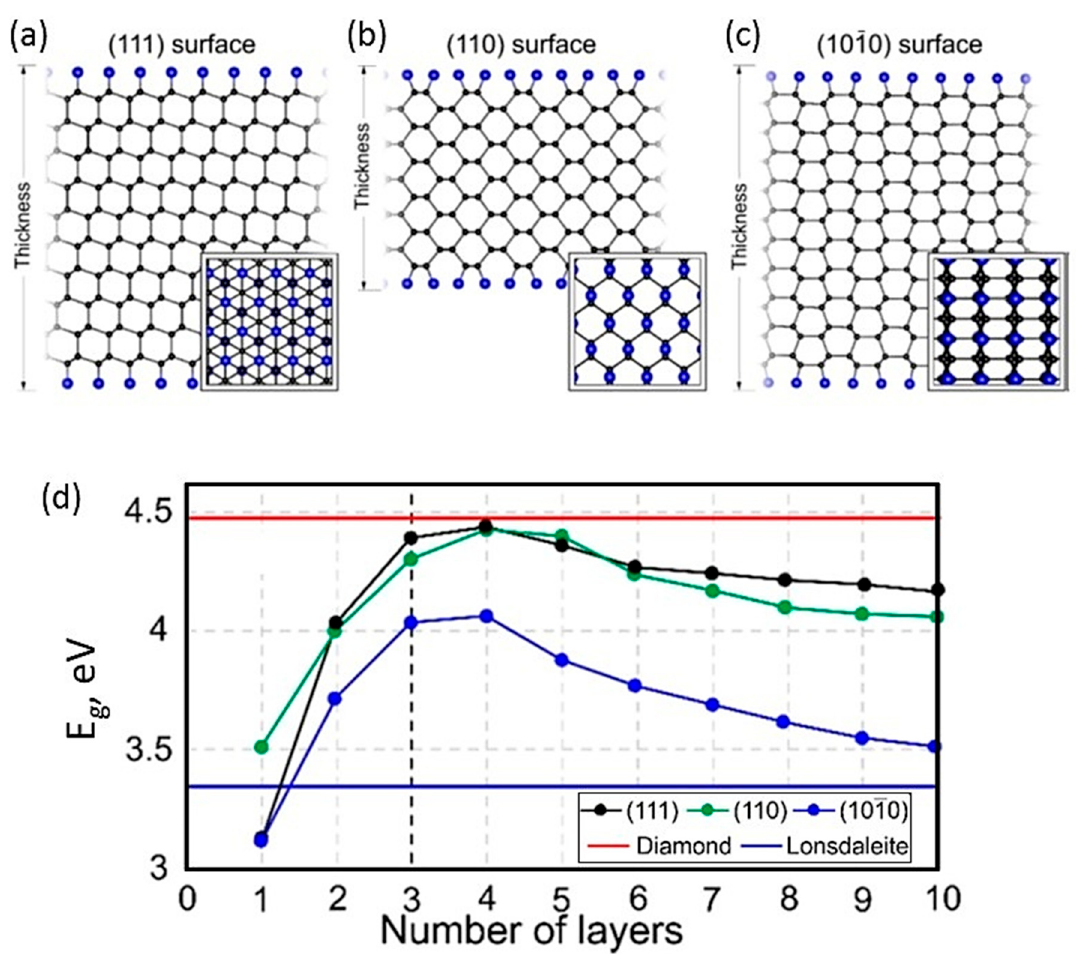
Figure 13. Atomic structures of considered fluorinated films [6] with 10 layers with ( a ) (111), ( b ) (110) and ( c ) (1010) surfaces (top views of the films shown in the insets; black color is carbon, and blue is fluorine), and ( d ) dependence of the bandgaps of the fluorinated cubic diamond films with (111) and (110) surfaces and hexagonal diamond film with (1010) orientation upon the number of layers (red horizontal lines are the bandgap of single-crystal diamond; blue lines correspond to bandgap of bulk lonsdaleite) [6].